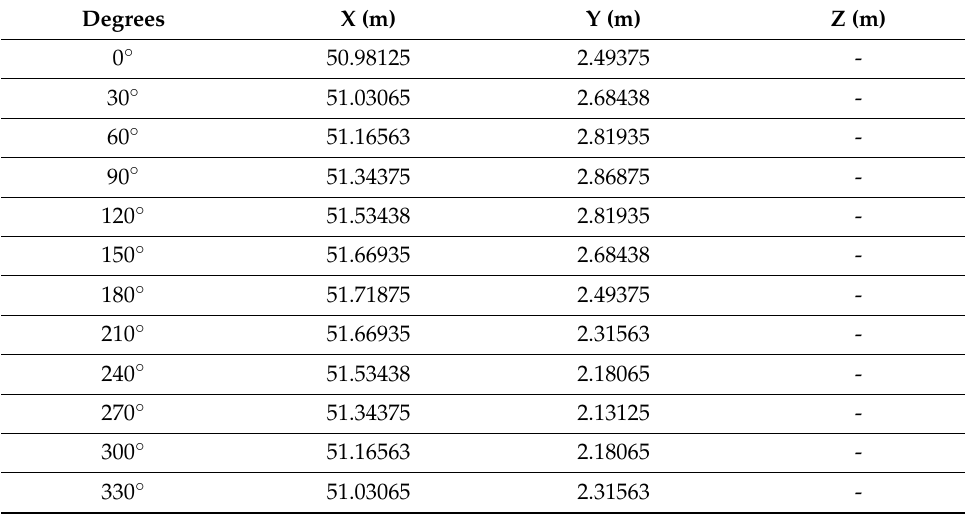
Table 4. Measuring positions around the substructures.